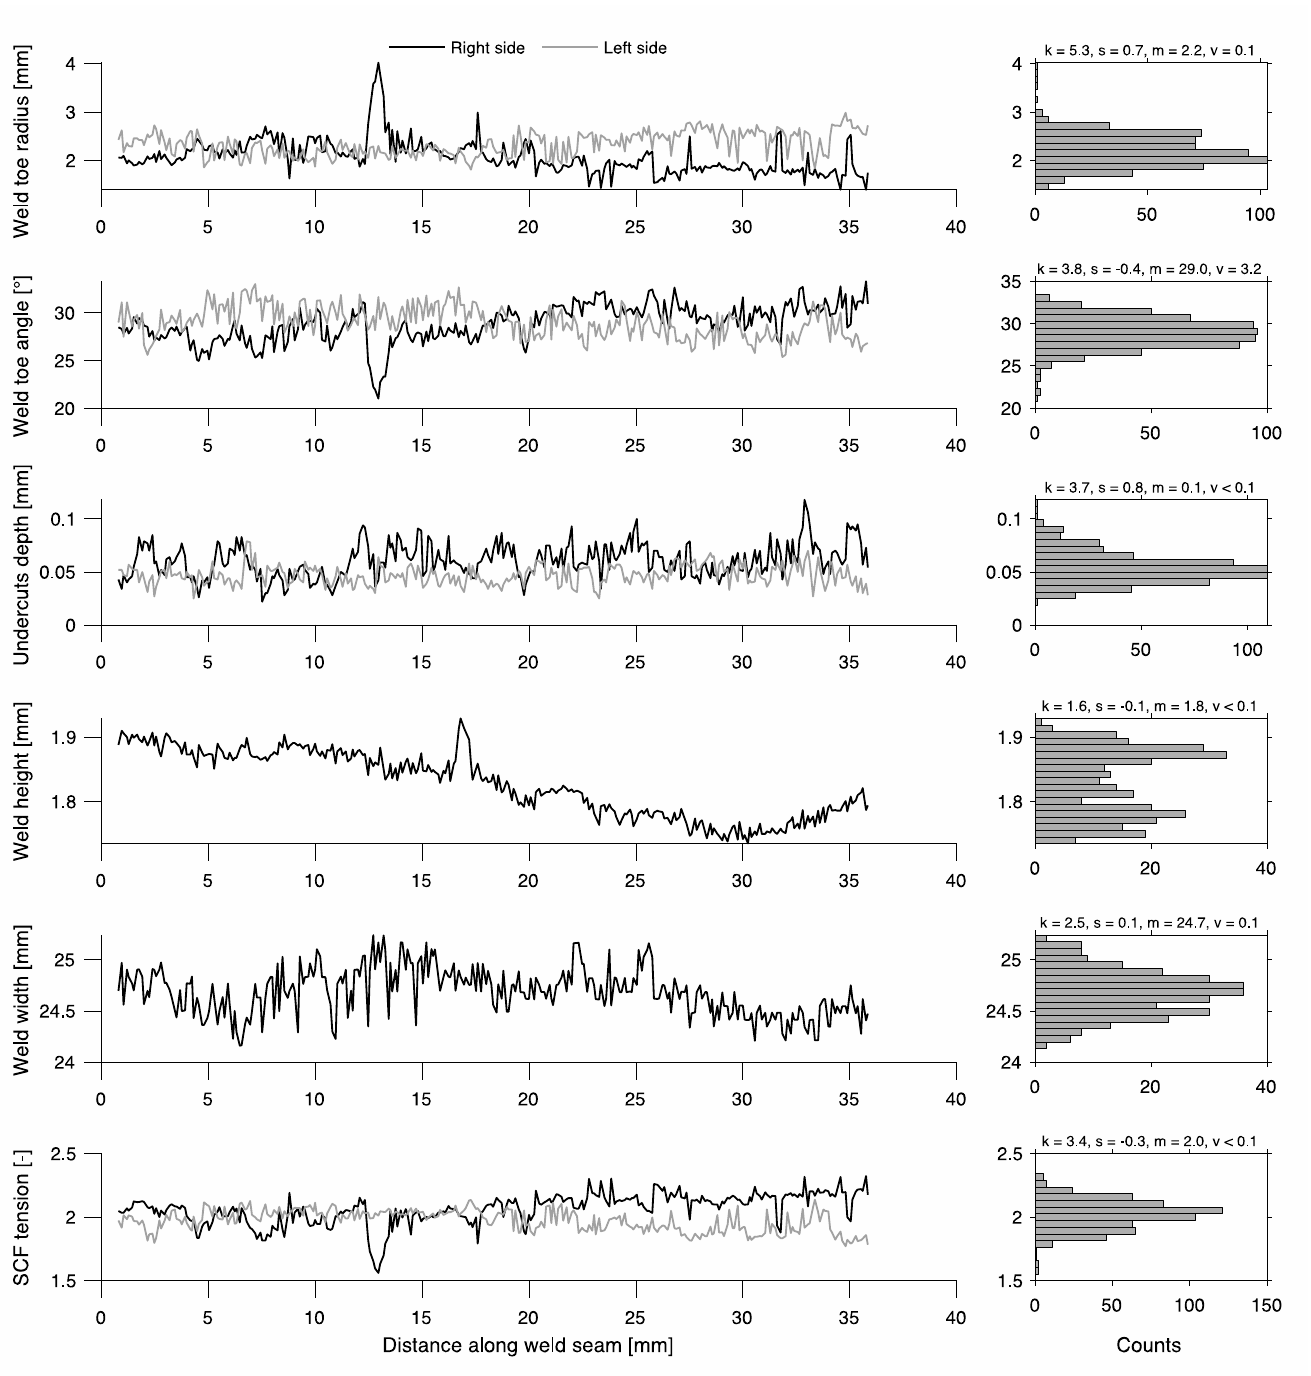
Figure 8. Change of weld geometry parameters and SCFs along exemplary weld seams.